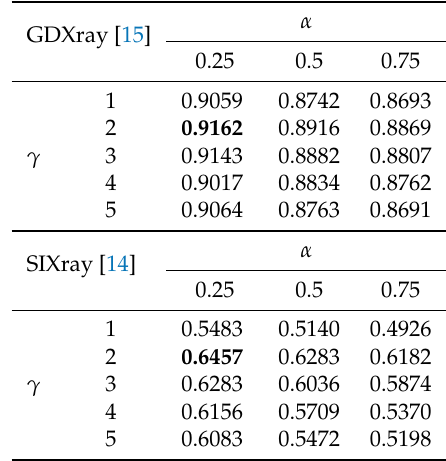
Table 2. Effect of varying focal loss parameters on the detection performance (in terms of mAP ) on GDXray [15] and SIXray [14] dataset. Bold indicates the optimal performance.